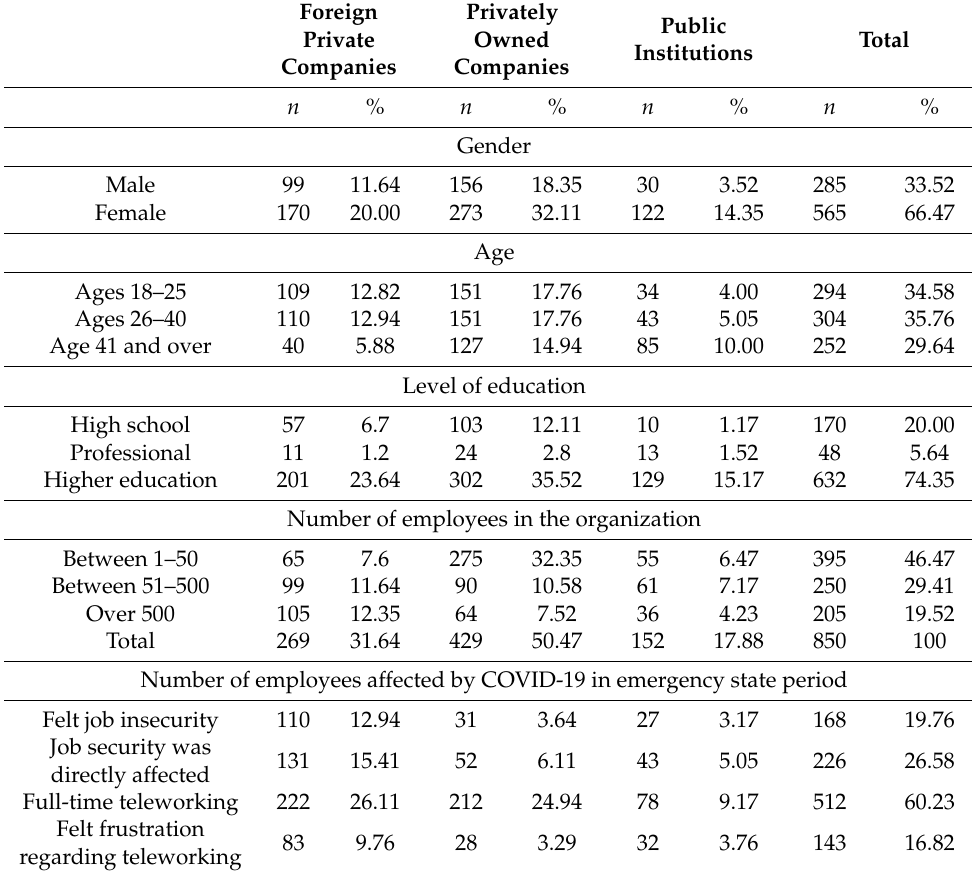
Table 1. The structure of the sampling according to the type of employing organizations ( n = 850).